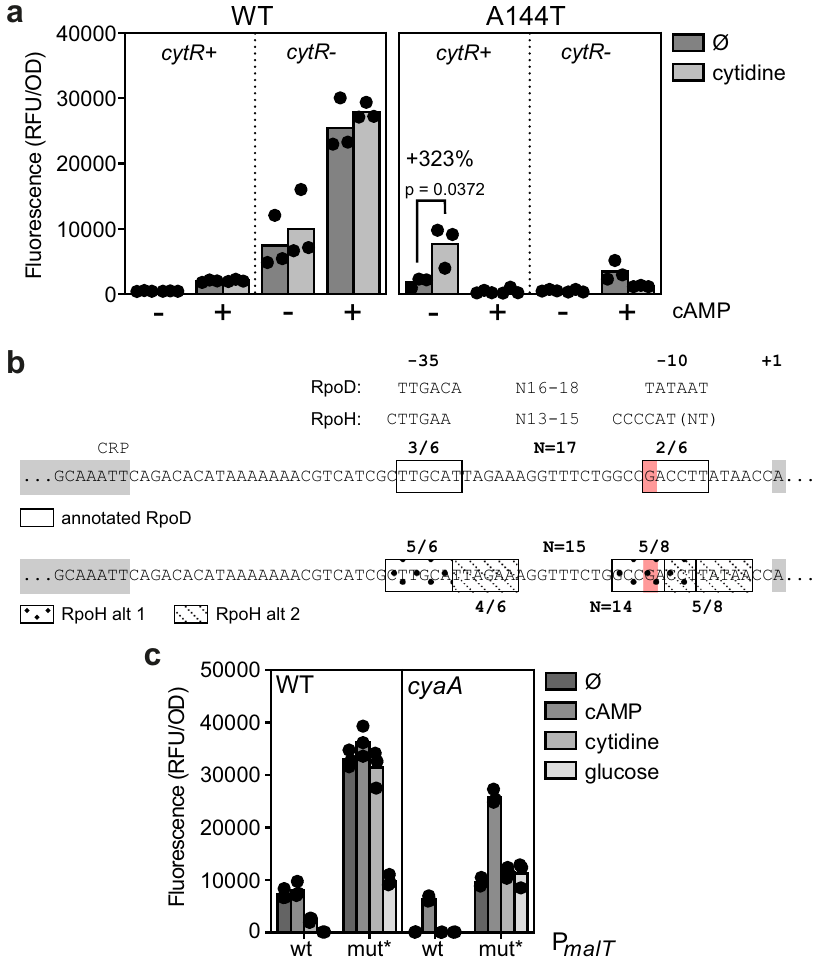
Fig. 8 The interplay of Crp and co-regulators on the studied promoters. a Reporter activity from the rpoH promoter in MG1655 cya crp cytR ( + /-) pSEVA- crp (Crp WT or A144T) in the presence (light grey) or absence (dark grey, Ø) of cytidine and cAMP (annotated by + / − ). Signi fi cance was based on two- sided unpaired t-tests between the groups indicated and designated as signi fi cant if p < 0.05. b Annotations of the malT promoter with a naturally occurring mutation in red. Top: RpoD and RpoH consensus sequences as reported in litterature 33, 50, 51 . Middle: RpoD annotation as reported in RegulonDB 52 . Bottom: Annotations for hypothetical RpoH recognition sites of the same promoter (two alternatives, alt 1 vs alt 2). c Reporter activity in MG1655 (WT or cya ) from the native malT promoter (WT) and from the malT promoter with the naturally occurring promoter mutation (mut*, G->T), when supplemented with (dark to light grey) nothing (Ø), cAMP, cytidine, or glucose. Data represent the average of three biological replicates. RFU relative fl uorescence units, OD optical